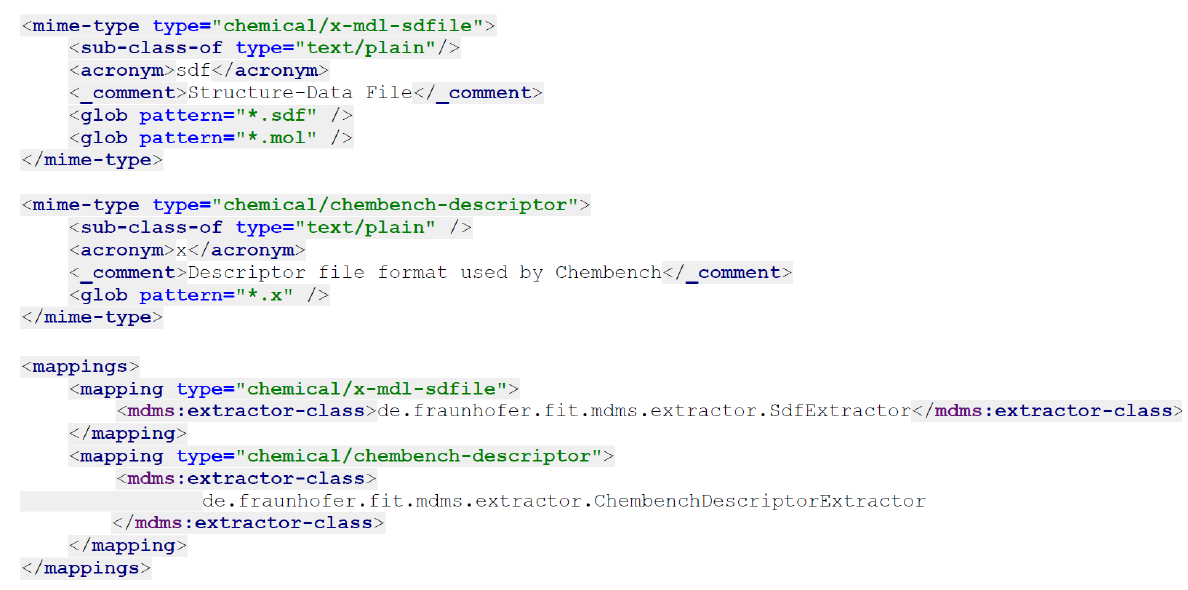
Figure 9. An excerpt from the application configuration file: introduction of new media types and a mapping between them and extractor